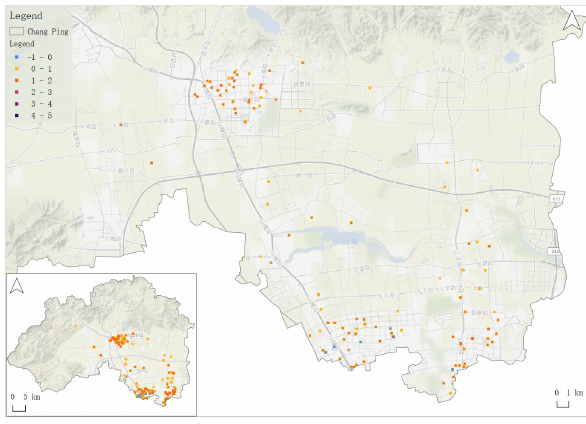
Figure 11. Sensitivity score of neighbourhoods in Chang